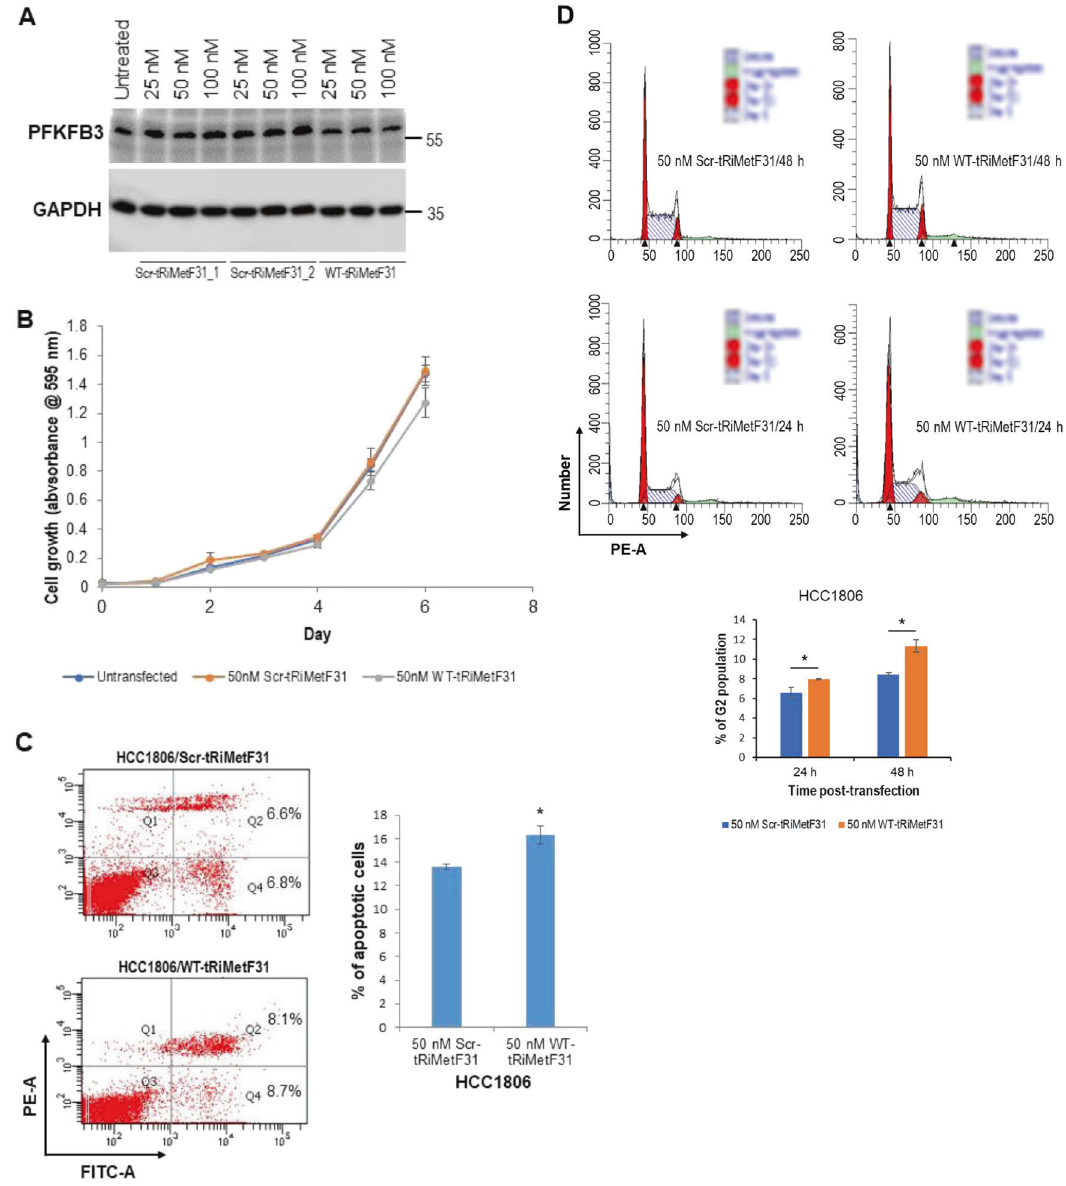
Fig. 3 Ectopic tRiMetF31 induced apoptosis and cell cycle arrest, while having no effect on the proliferation of HCC1806 cells. A HCC1806 cells were transfected with either Scr-tRiMetF31_1 or Scr-tRiMetF31_2 or WT-tRiMetF31; at 48 h after transfection, whole cellular lysates were prepared and subjected to western blot analysis using antibody against PFKFB3. B At 24 h after transfection, cells were replated in 96-well plates, and MTT assay was performed as detailed in the “ Materials and methods ” . C , D HCC1806 cells were transfected with either 50 nM WT- tRiMetF31 or 50 nM Scr-tRiMetF31_2; at 24 h and/or 48 h after transfection, cells were harvested for apoptosis and cell cycle analyses, as detailed in the “ Materials and methods ” . * indicates P <